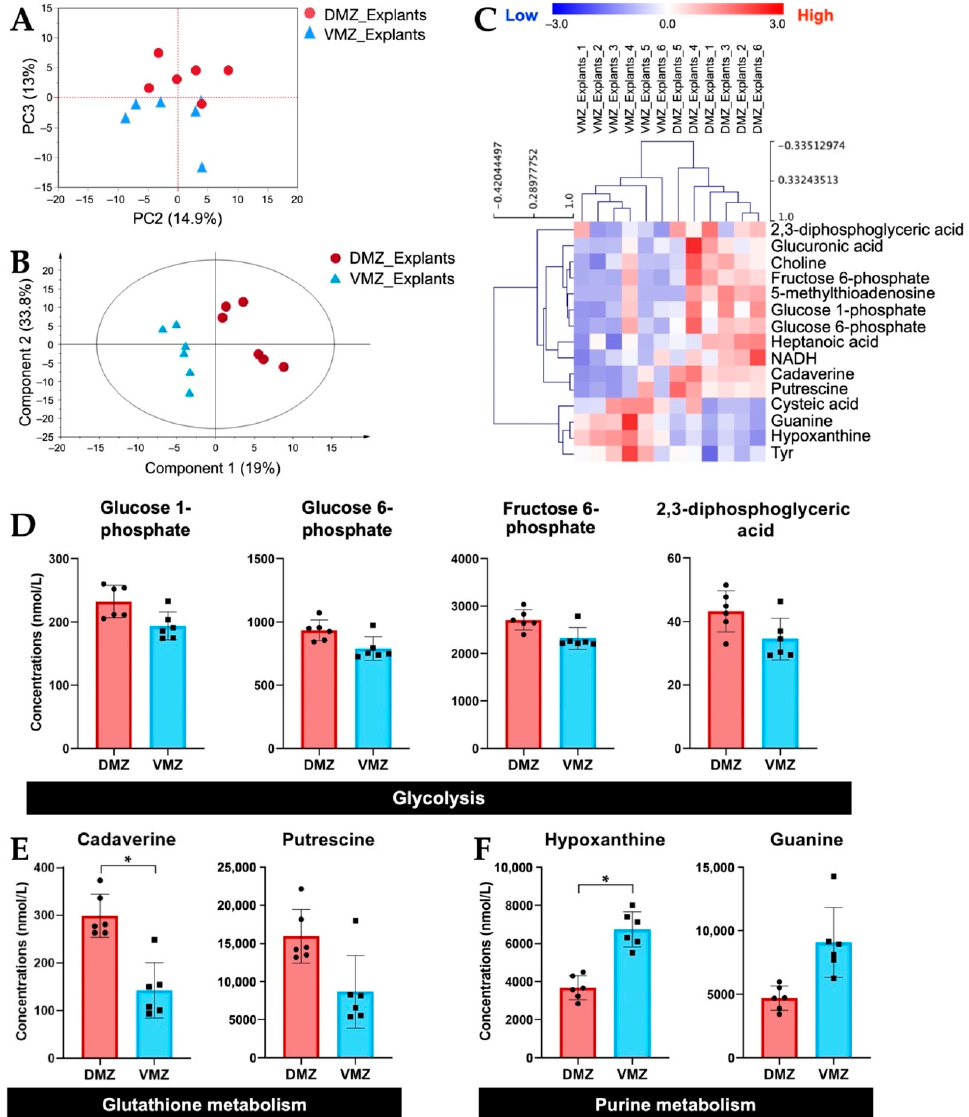
Figure 2. Identification of hydrophilic metabolites differentially expressed between the DMZ and VMZ in explants (DMZ and VMZ explants). ( A ) Principal component analysis (PCA) score visualizing the relationship between the DMZ (red circle) and VMZ (blue triangle) explants using hydrophilic metabolites. The contribution ratios were 14.9% and 13% for PC2 and PC3, respectively. ( B ) Partial least squares–discriminant analysis (PLS-DA) score plots for the DMZ (red circle) and VMZ (blue triangle) explants. ( C ) Hierarchical clustering analysis (HCA) for the top 15 metabolites by variable importance in projection (VIP) scores in explants. Rows display the metabolite, and columns represent the sample. Metabolites with relatively low contents are displayed in blue, whereas metabolites with relatively high contents are displayed in red. The brightness of each color corresponds to the magnitude of the difference compared with the mean value. The number at the end of each sample name corresponds to samples made from the same embryos. ( D – F ) Comparison of the concentrations of metabolites that differed notably between the DMZ and VMZ explants. Symbols represent each sample, and the bar graph indicates the mean ± SD ( n = 6, each sample from 20 explants). * FDR adjusted p < 0.05 (Welch’s t -test, Benjamini–Hochberg procedure). ( D ) Bar graphs of the metabolites involved in glycolysis in the top 15 metabolites by VIP scores. ( E ) Bar graphs of the metabolites involved in glutathione metabolism in the top 15 metabolites by VIP scores. ( F ) Bar graphs of the metabolites involved in purine metabolism in the top 15 metabolites by VIP